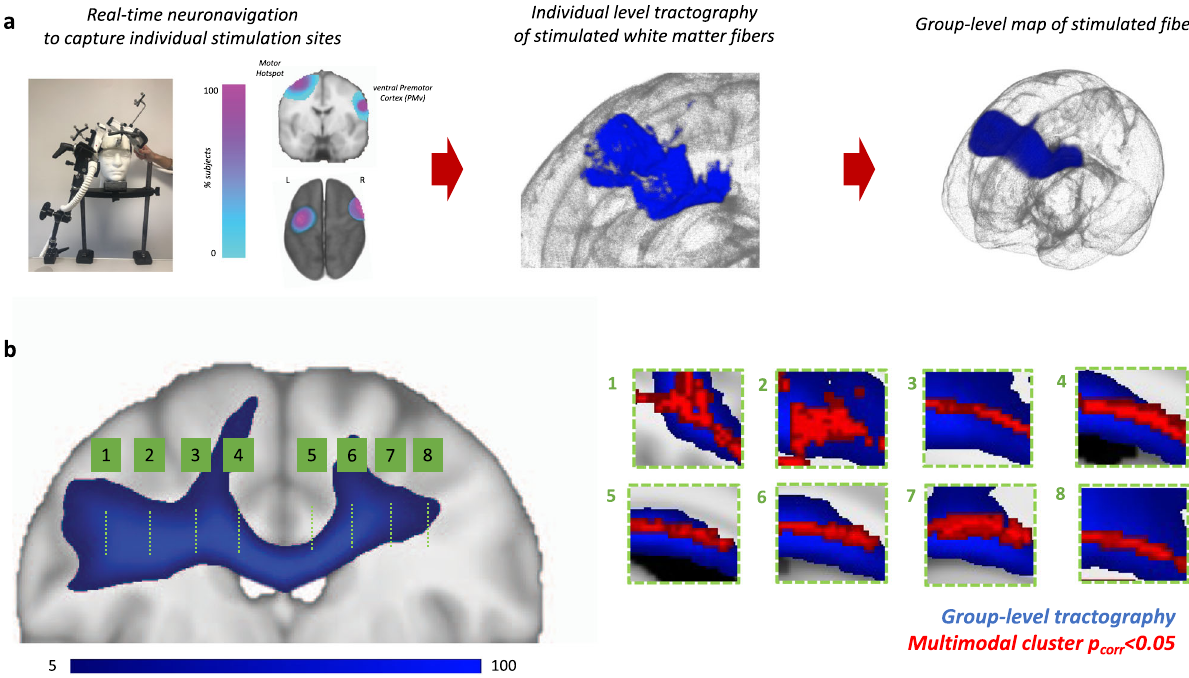
Fig. 4 Tractography of stimulated white matter fi bres. a We estimate individual-level and group-level maps of white matter fi bres stimulated in our paradigm. b Left: the group-level map of tract overlap across subjects is shown in blue, overlaid on a coronal section. Locations for sagittal sections are indicated in green. Right: sagittal sections showing anatomical overlap between stimulated fi bres (blue) and the cluster where myelin metrics correlate with stimulation-based metrics of cortico-cortical interactions